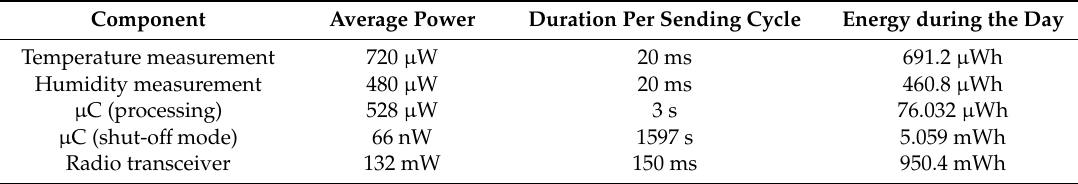
Table 6. IoT sensor energy